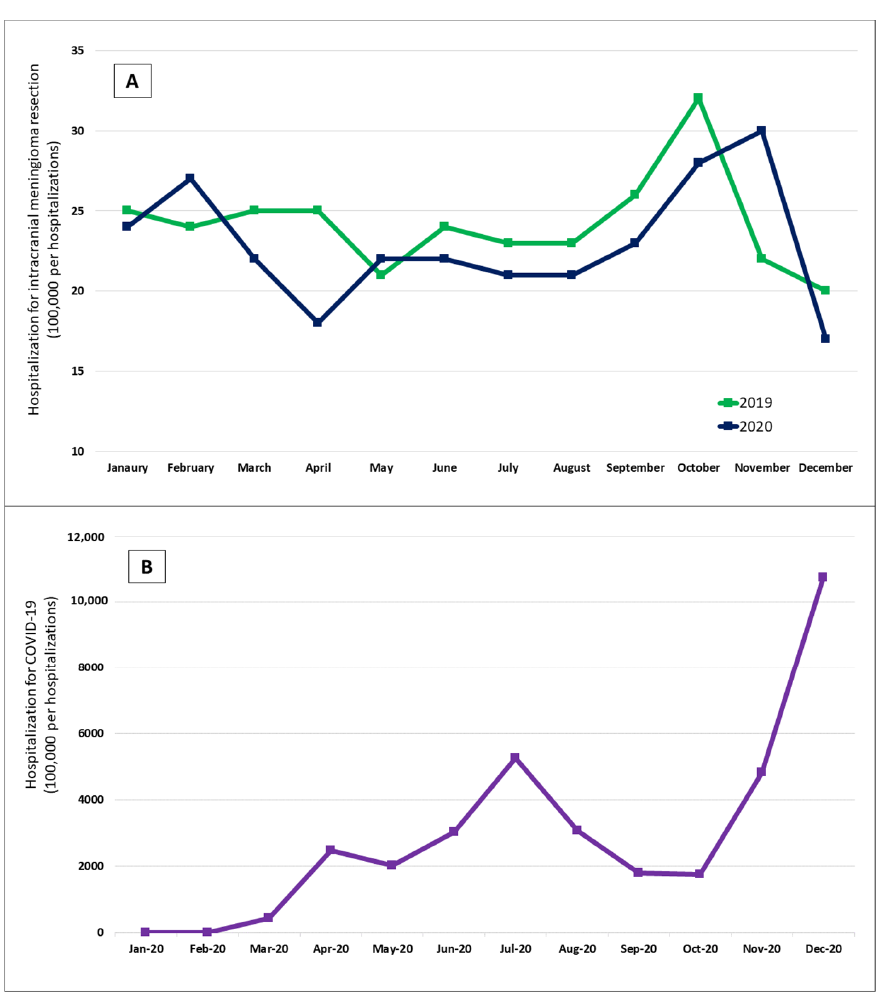
Figure 1. Trends in hospitalizations for intracranial meningioma resection during 2019 and 2020 ( A ) and COVID-19 hospitalizations during 2020 ( B ).